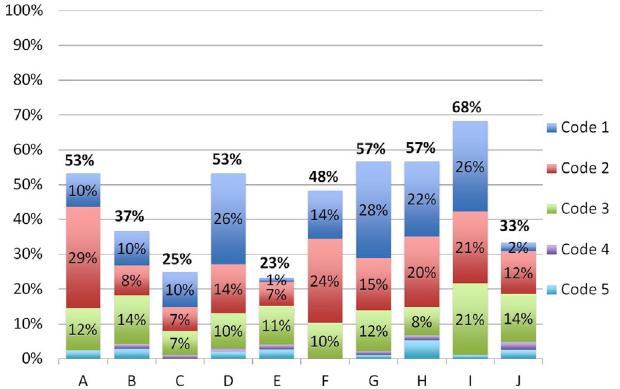
FIG. 5. The composition of social positions for each group in “ energy bar-chart ” activity, episode 3. Columns represent per- centage of 1, 2, 3, 4, and 5 codes as a fraction of total number of codes, scaled by the amount of coded time.